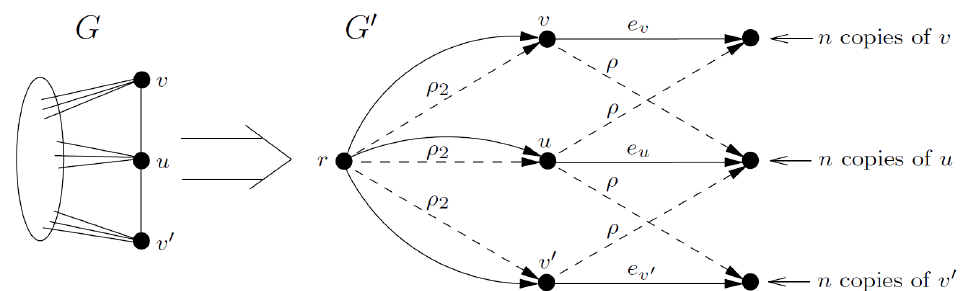
Figure 1. An example of the reduction defined in Theorem 1 for the graph G on the left side. The DAG G (cid:48) restricted to the vertices u , v , v (cid:48) of G is shown on the right side. Dashed edges are fixed-cost edges while the other edges of G (cid:48) are owned by the leader. Observe that the distance from r to v (cid:48) does not depend on the price set on the edge ( r , v ) but depends on the price set on the edge ( r , u ) . This is because { v , v (cid:48) } is an independent set of G while { u , v } is